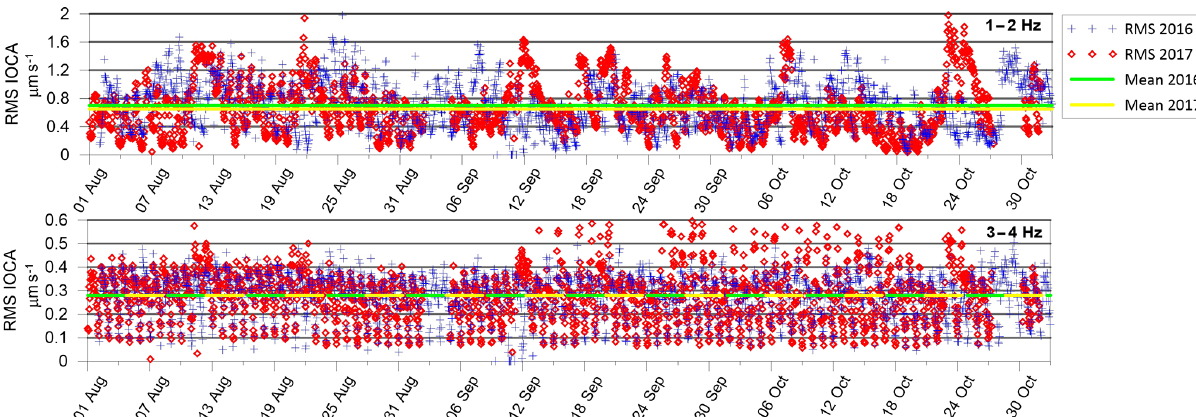
Figure 5. Time evolution of the RMS of the seismic noise recorded during the time interval August–October 2016 (blue) and 2017 (red), in the 1–2 and 3–4Hz frequency bands. The mean value of the RMS is indicated by the green (2016) and yellow (2017) lines. Note that we used different scales for the y axis, due to the different energy content in the two bands.